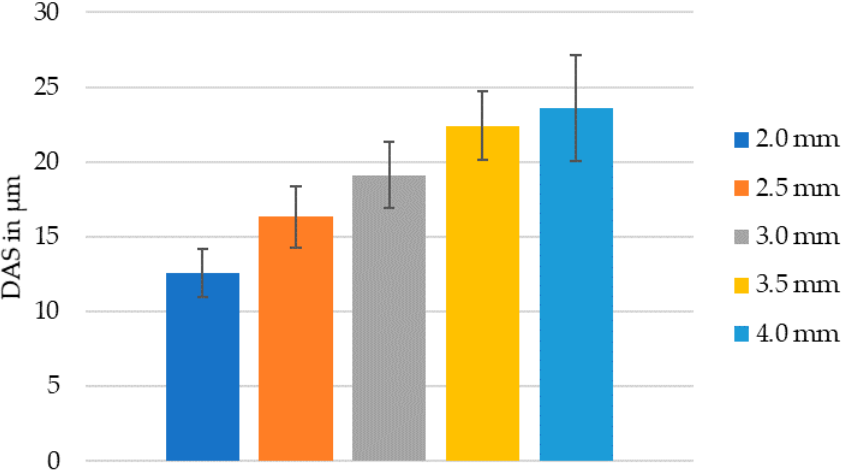
Figure 5. DAS of the aluminium casting alloy AlSi9 with a thickness between 2 and 4